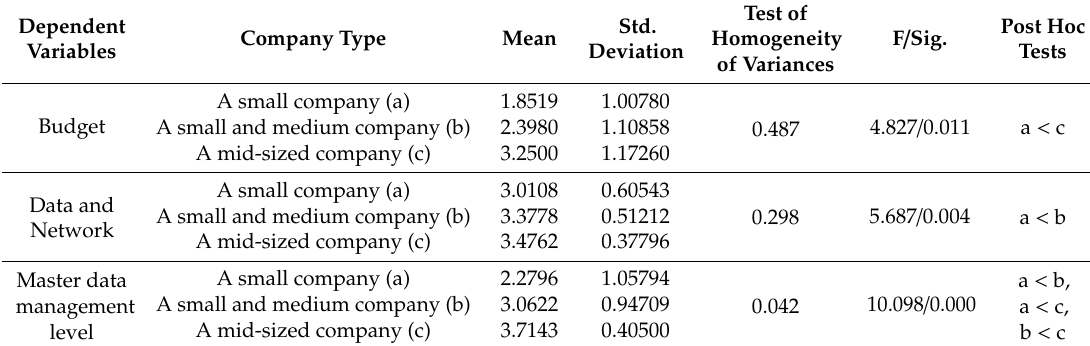
Table 9. One-way ANOVA